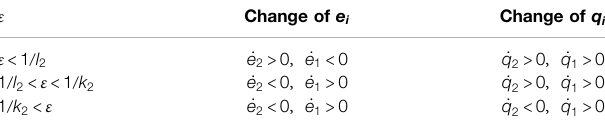
TABLE 2 | The behaviors of fi rms without a BB system (when ρ > 0). Change of e i Change of q